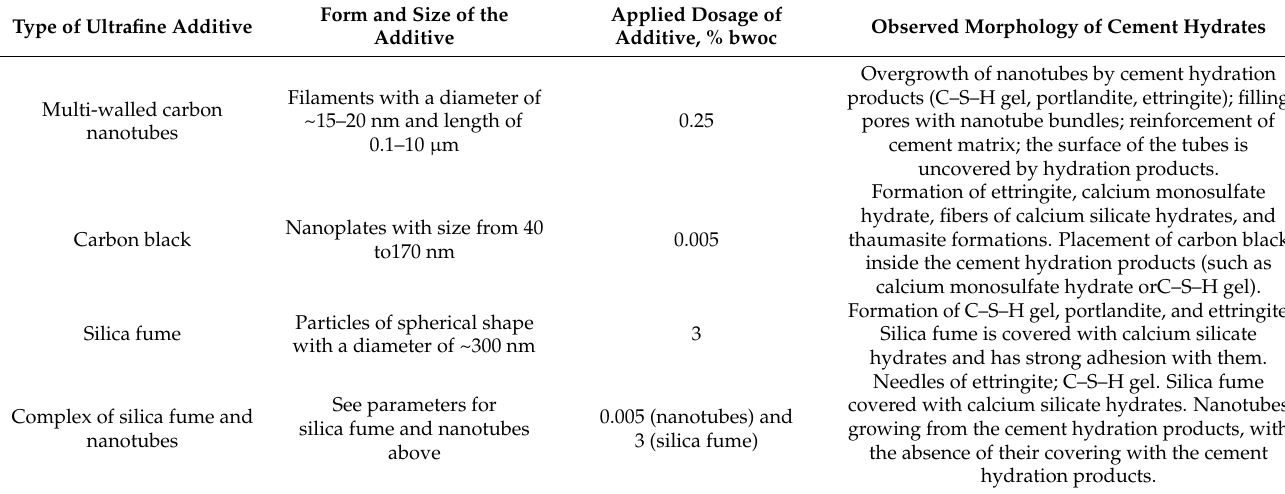
Table 6. Features of the morphology of hardened cement paste modified with ultrafine additives of different